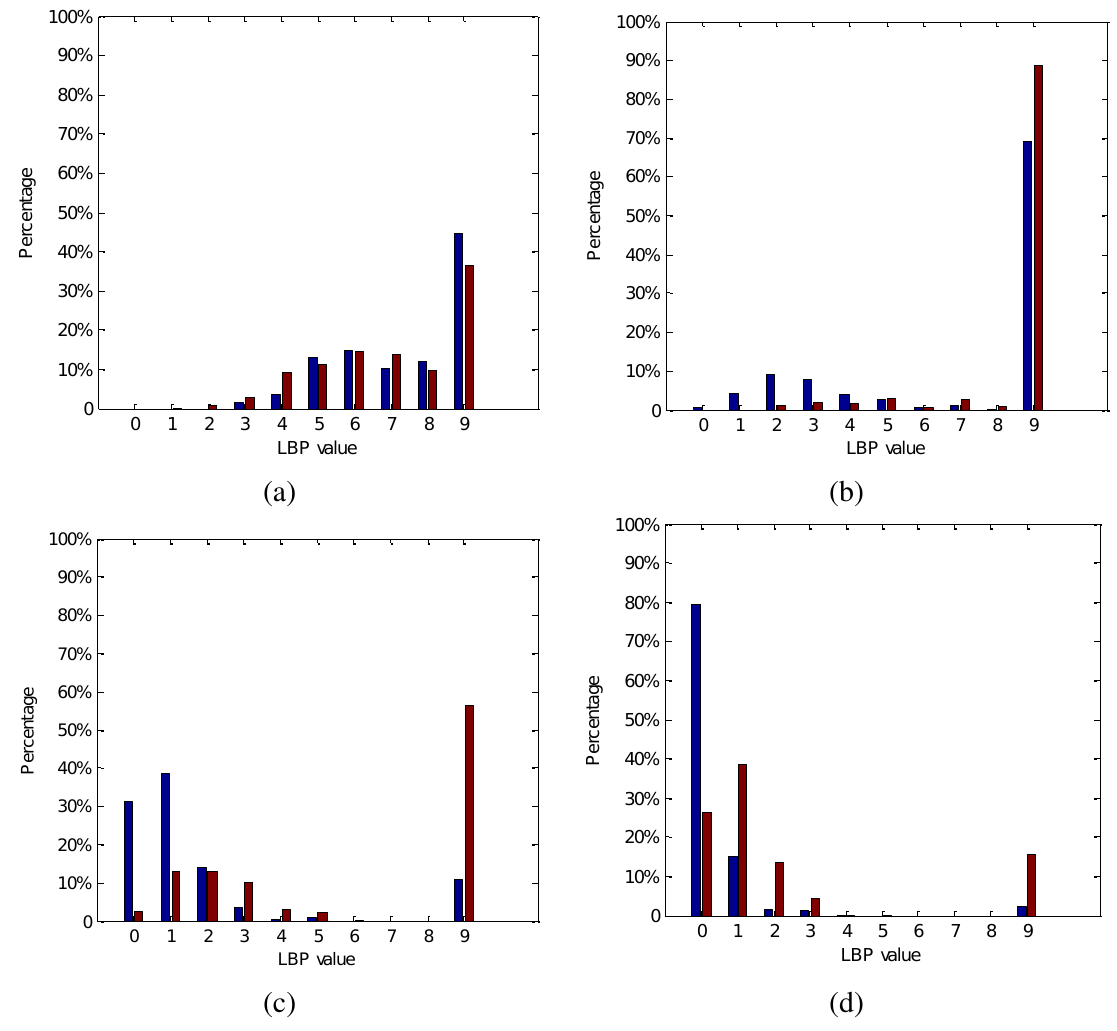
Figure 5. The LBP riu 2 and LBP riu 2 ,T value distributions of the heterogeneous regions in 8 , 1 8 , 1 Figure 4a: ( a ) RIU-LBP; ( b ) RHLBP (T = 10); ( c ) RHLBP (T = 20); ( d ) RHLBP (T =